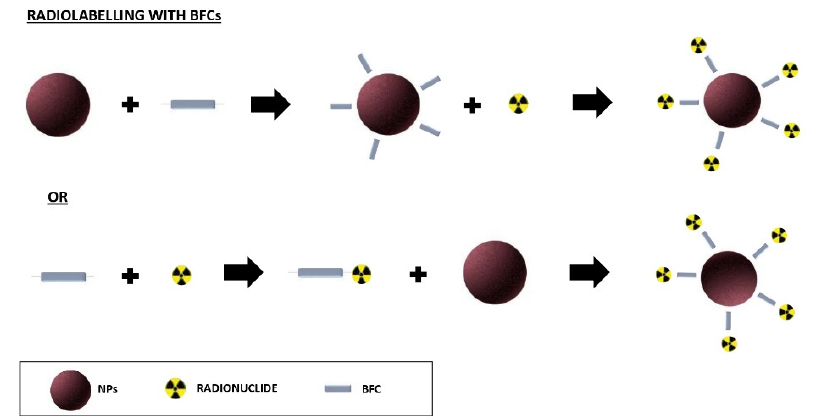
Figure 1. Different approaches to radiolabel NPs using BFCs.